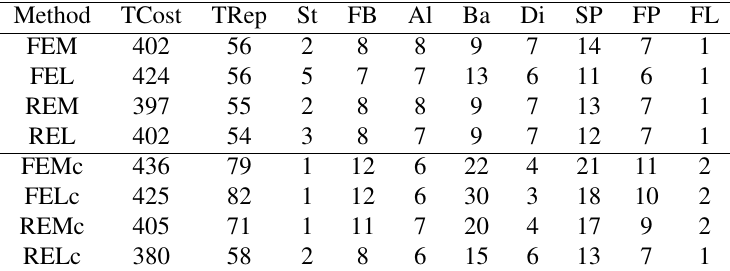
Table 12. Results of DAP when π SP increases to 5.